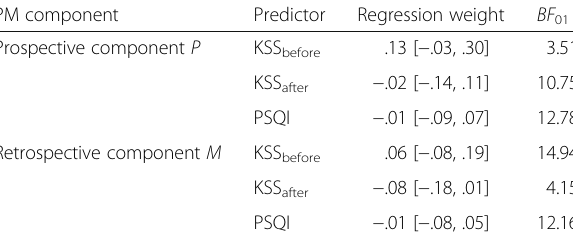
Table 2 Unstandardized regression weights, 95% Bayesian credibility intervals, and Bayes factors for all predictors in Study